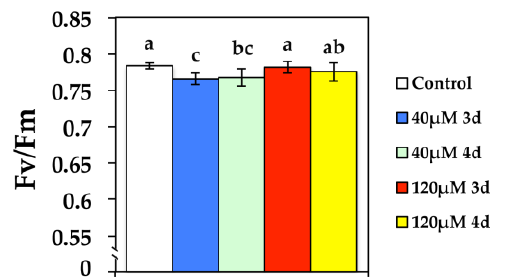
Figure 1. Changes in the maximum quantum efficiency of PSII ( F v / F m ) in N. caerulescens plants grown at 0 (control), 40 or 120 μ M Cd 2+ for 3 and 4 days.